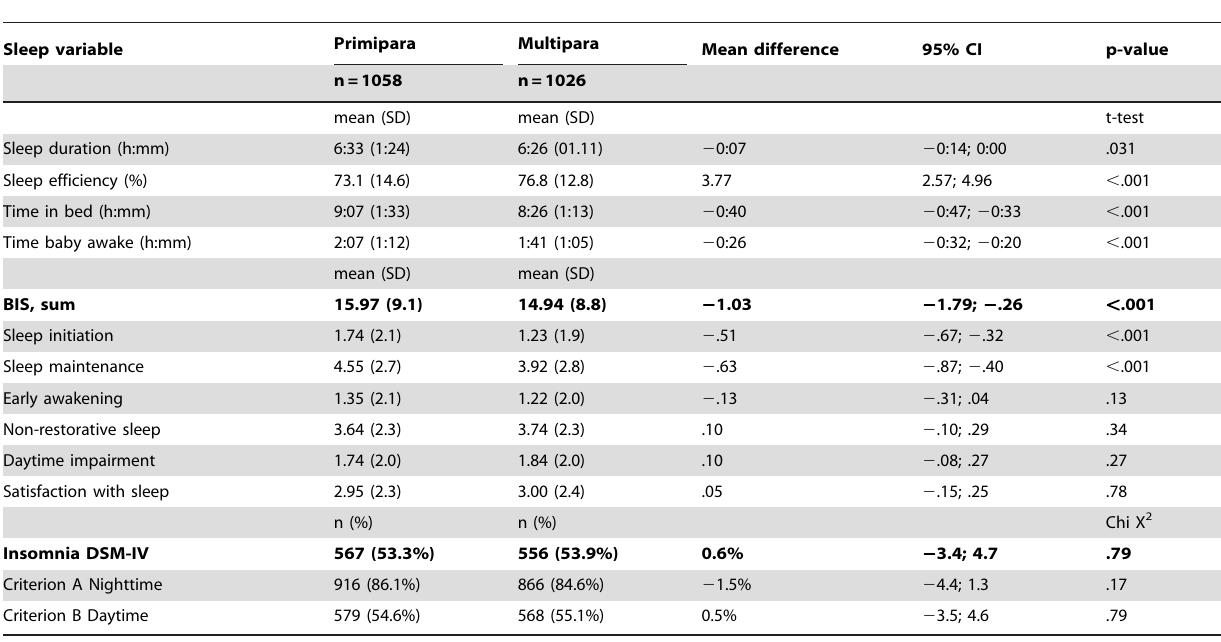
Table 2. Sleep after delivery, according to parity among 2088 women.